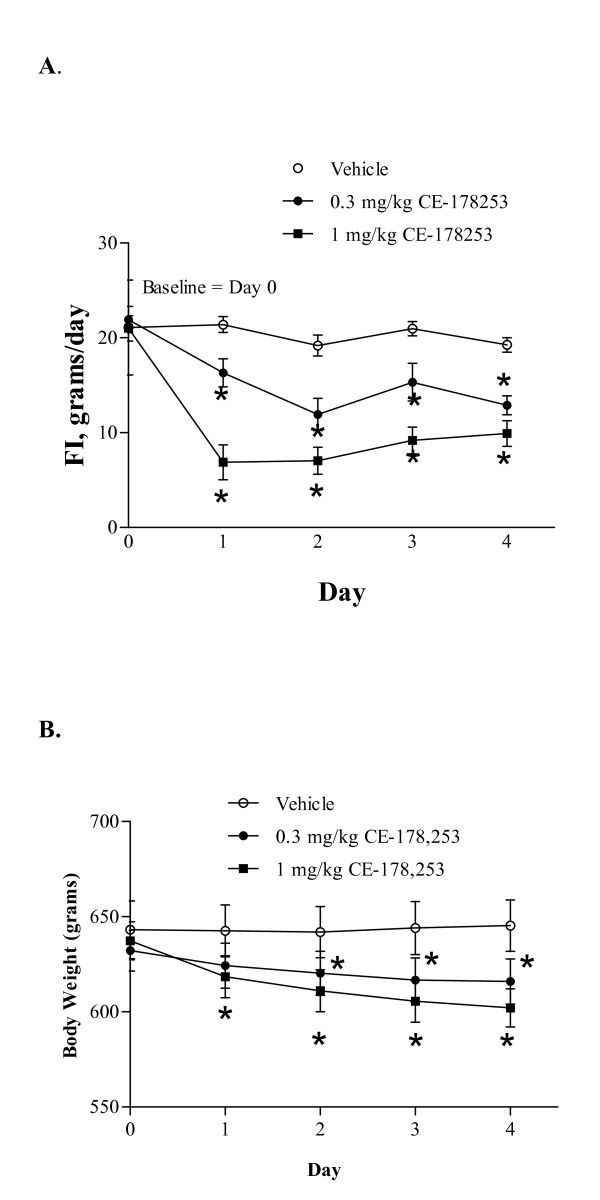
Effect of CE-178253 on FI (6A) and BW (6B) in DIO rats. FI and BW were measured in DIO rats (weight = 643 ± 15 g (Veh.), 632 ± 11 (0.3 mg/kg CE-178253) 637 ± 11 (1 mg/kg CE-178253); mean ± SEM, n = 8/group) daily after once daily administration of veh. (0.5% MC) or CE-178253 at either 0.3 mg/kg or 1 mg/kg p.o. FI data shown are the total amount of food consumed expressed in energy grams consumed for each day of treatment. The mean ± SEM (n = 8/group) is shown. * = p < 0.05 vs. veh.